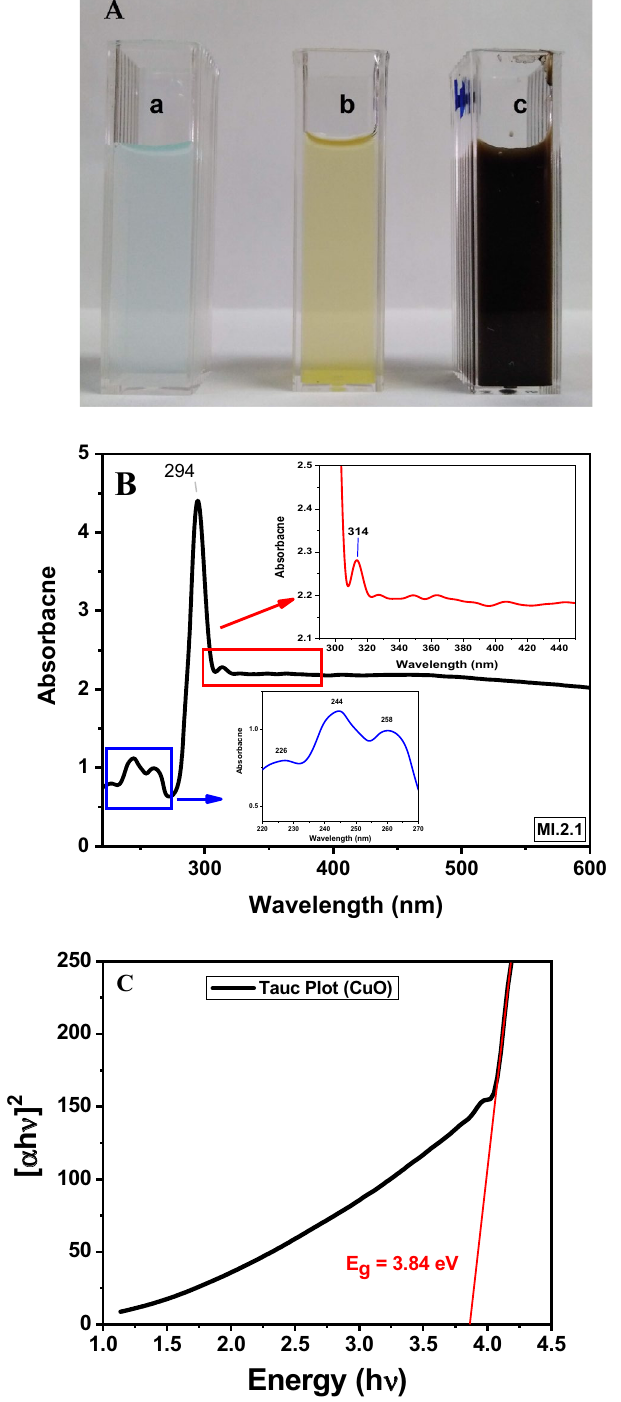
Figure 2. ( A ) Photograph of sample changing color (a) aqueous CuSO 4 solution, (b) aqueous extract of Rhazya stricta , (c) aqueous solution of CuO NS. ( B ) UV visible absorption spectrum of CuO nanosheets. ( C ) Tauc’s plot showing the energy bandgap of CuO NS. Both absorption spectrum ( B ) and Tauc’s plot ( C ) were produced by OriginPro 2018